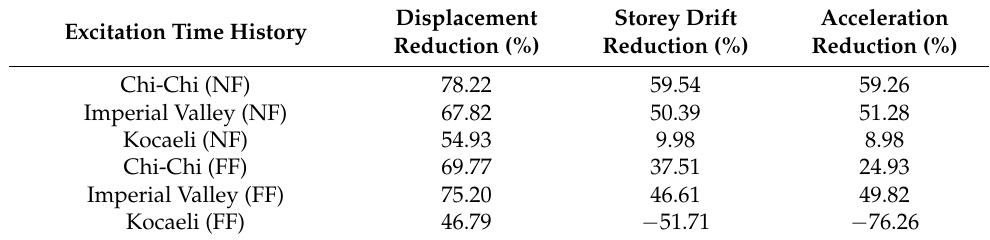
Table 6. Percentage response reductions.